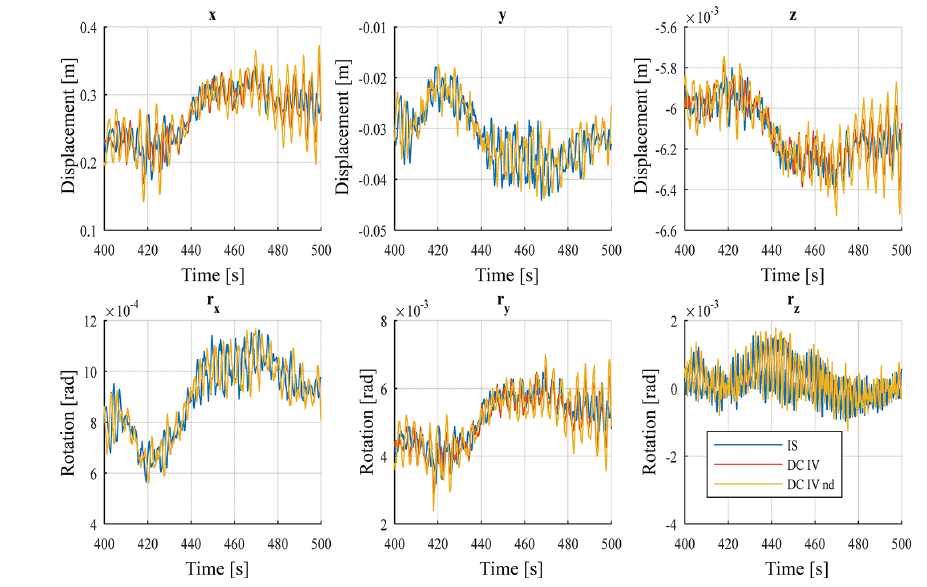
Figure 17. Time-history response for tower top displacements of DC IV with a wind speed of 8ms − 1 . The yellow curve (DC IV nd) shows the time-history response for a decoupled model with full rotor loads and no damper (nd) applied.